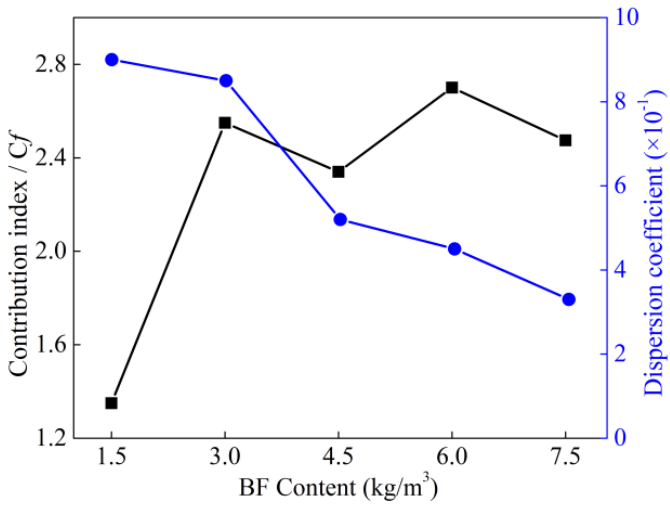
Figure 9. BF average contribution index under different BF contents.